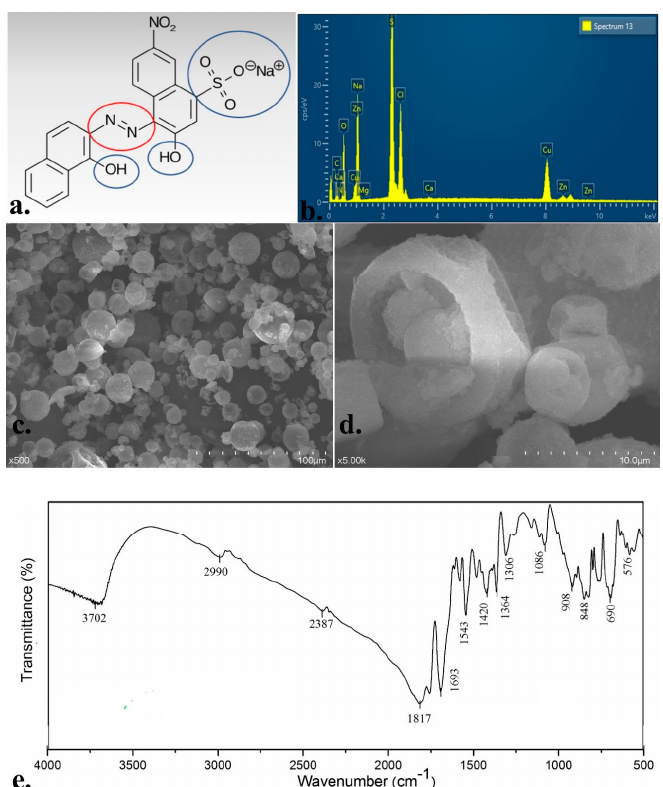
Figure 1. Dye-related characteristics, ( a ) chemical structure, where the red circle is the chromophore group, and blue are the auxochromes, ( b ) EDX spectra of the dye, ( c ) scanning eclectron microscopy (SEM) images of EBT at 500 magnification, ( d ) SEM images of EBT at 5 k magnification, ( e ) Fourier-transform infrared spectroscopy (FTIR) spectra of EBT dye.